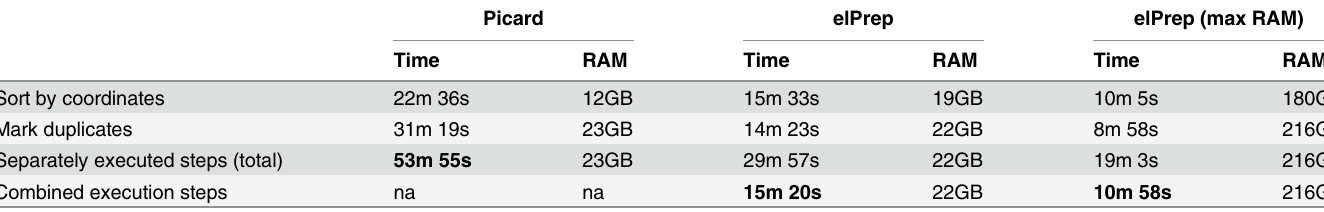
Table 1. Benchmarks of the 2-step pipeline on NA12878 exome (Basic protocol 1).